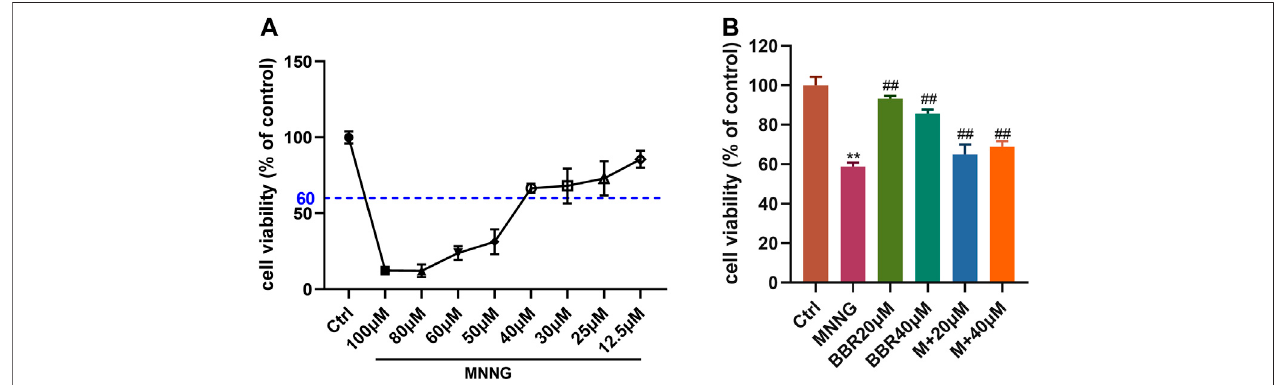
FIGURE2| EffectofMNNGandBBRoncellviabilityofGES-1cells (A) CellsurvivalrateofGES-1cellstreatedwithdifferentdosesofMNNGfor24 h (B) Protective effect of berberine pretreatment on proliferation of MNNG co-cultured GES-1 cells. Data were shown as mean ± SD ( N (cid:1) 5). ** < 0.01 vs. control group. ## < 0.01 vs. MNNG group. Ctrl, Control; M,